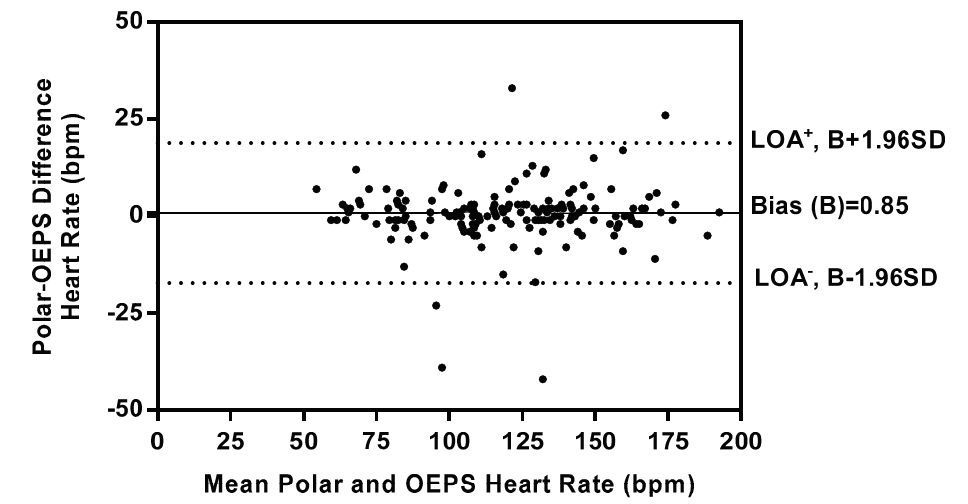
Figure 18. Bland-Altman plot shows differences in HR outputs recorded at rest and during differing exercise modalities and intensities using Polar and the OEPS. Mean bias (solid line) and limits of agreement (dashed line) are also